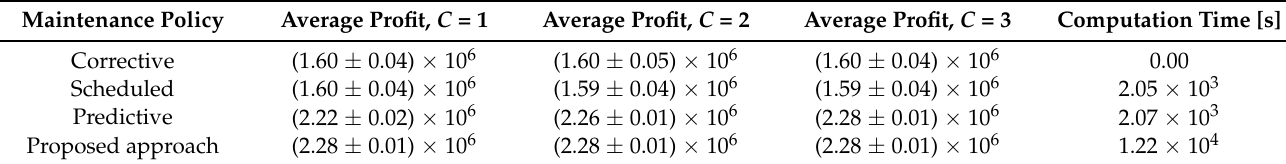
Table 1. Performance of the tested policies in terms of average profit over 100 test episodes. Maintenance